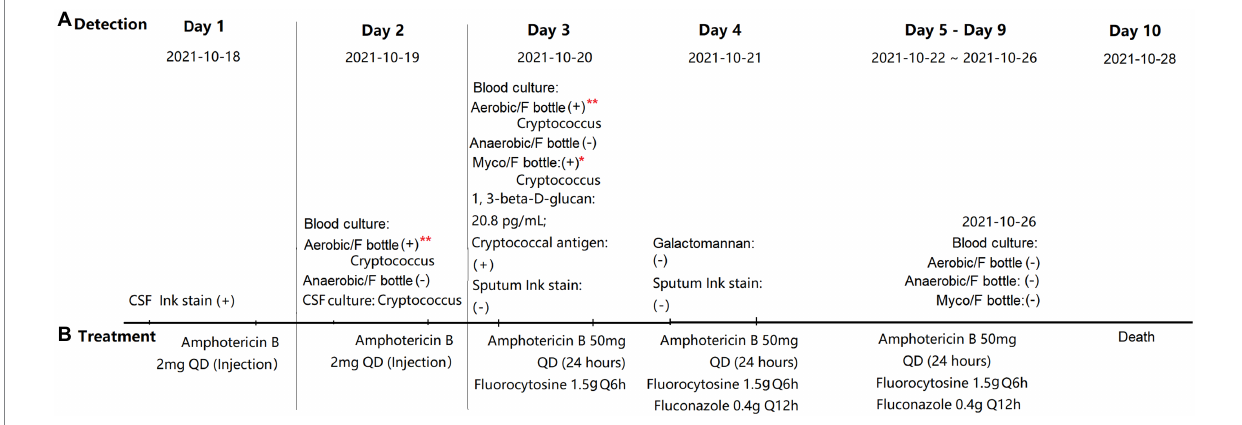
FIGURE 2 Detection (A) and treatment (B) of Cryptococcus neoformans infection. *Defined as positive by the BACTEC ™ FX system at 82 h; **defined as negative by the BACTEC ™ FX system at the end of 5 days but C. neoformans was detected on subculturing and yeast-like cells were observed by Gram staining. ER, emergency room; ICU, intensive care unit; CSF, cerebrospinal fluid; QD, means once a day. Q6h, means take medicine every 6 h; and Q12h, means take medicine every 12